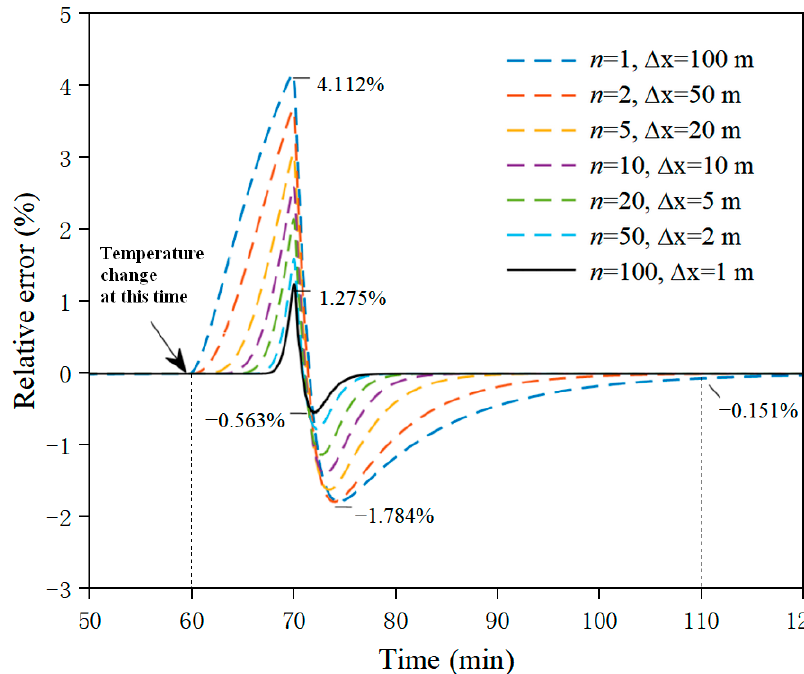
Figure 9. The relative error of the calculated results of pipe outlet temperature.